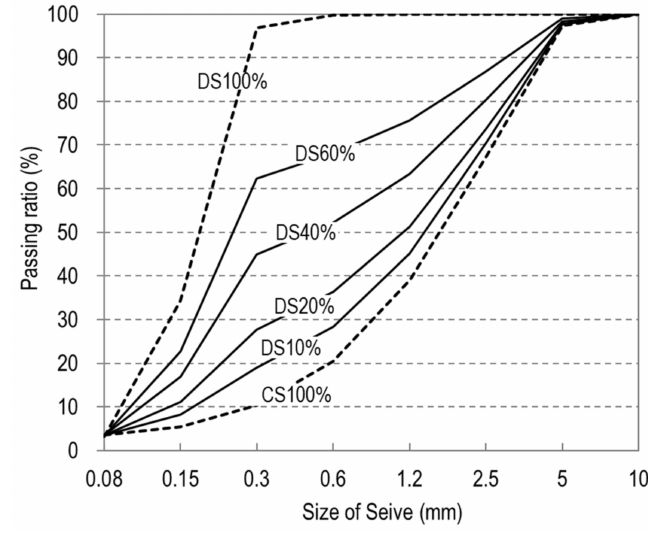
Figure 3. Particle size distribution of sand with DS